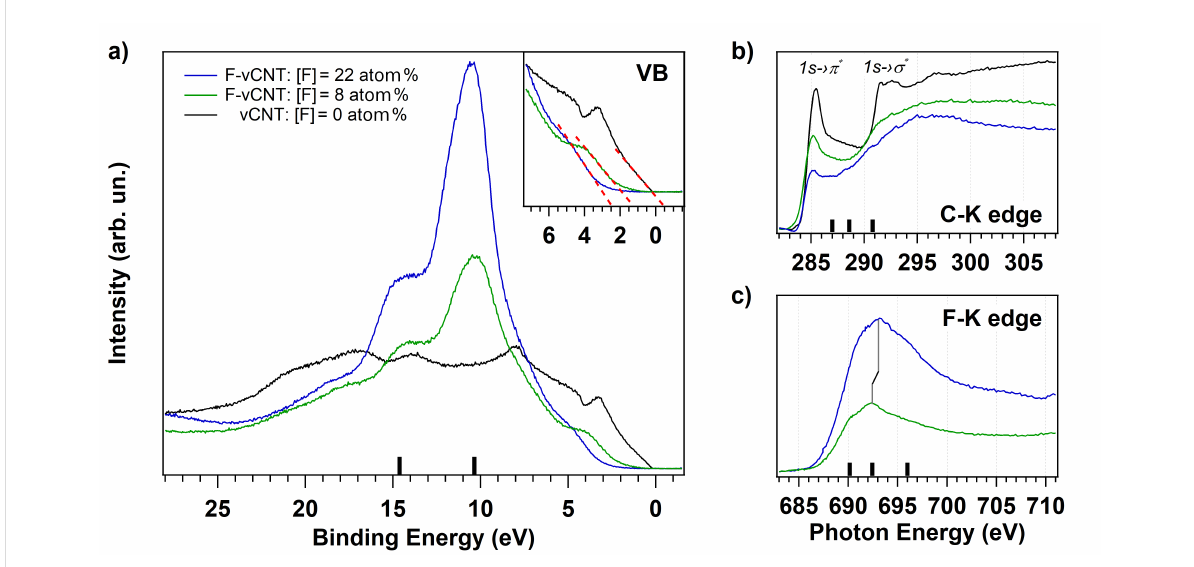
Figure 5: (a) Valence band spectra acquired from pristine (black line) and fluorinated vCNT with different fluorine content (22 atom %, blue line, and 8 atom %, green line). A close-up of the region near the Fermi level is depicted in the frame. For the same conditions, the absorption spectra acquired at C–K edge and F–K edge are reported in b) and c), respectively.